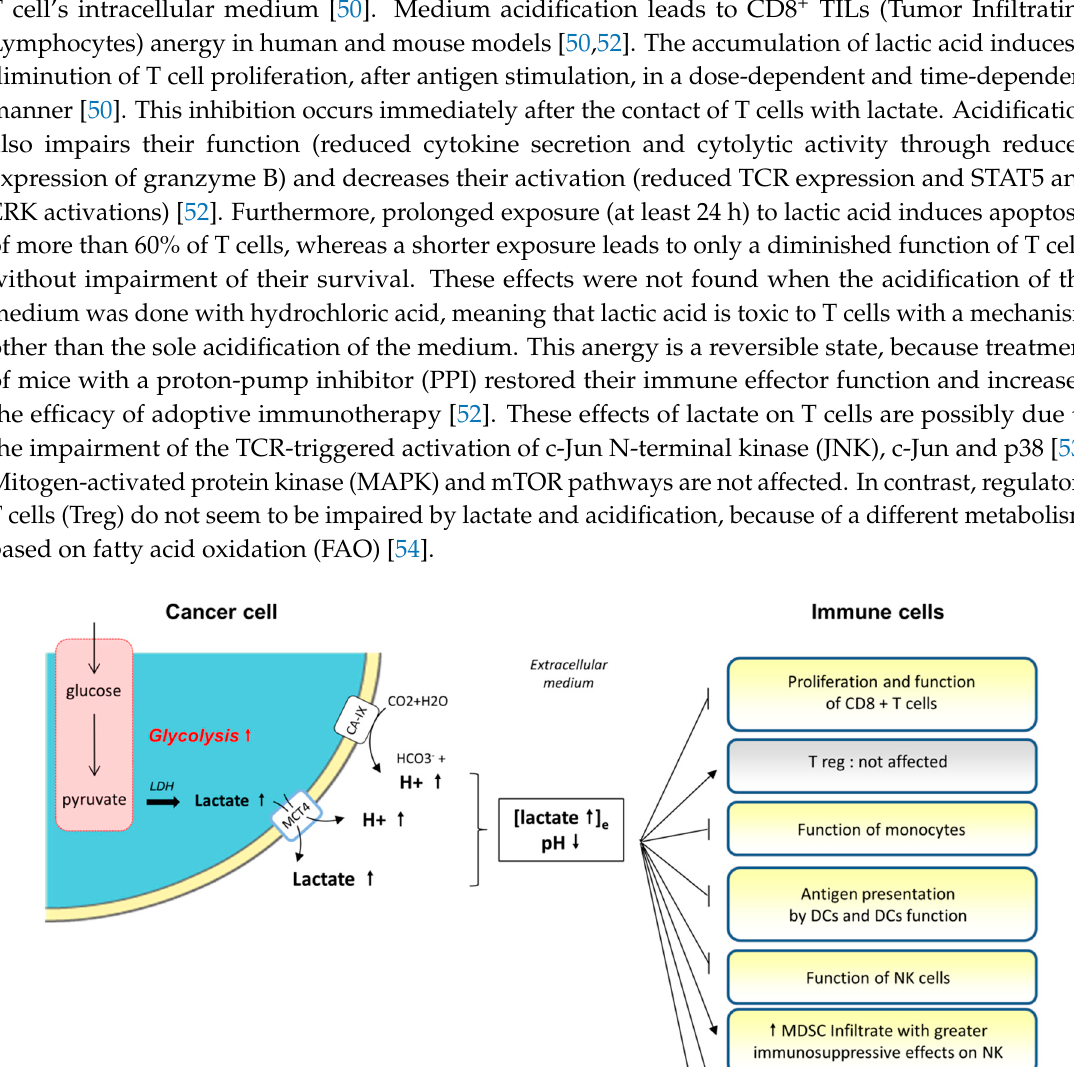
Figure 2. Cancer cells induced-lactate and -proton release within the peritumoral environment and the consequences for immune cell function. The metabolic switch towards aerobic glycolysis observed in most cancer cells (i.e., Warburg’s effect) produces significant amounts of pyruvate that are mostly metabolized into lactate. The intracellular increase of lactate, potentially toxic for the cancer cell, is then released into the extracellular medium together with protons (thanks to transporters such as MCT4), inducing an acidification of the local environment. The frequent up-regulation of carbonic anhydrase IX (CA-IX) in cancer cells also contributes to the local increase of H+ in the immediate neighborhood of cancer cells. Both, the accumulation of lactate and the decrease in the pH of the extracellular milieu create a detrimental environment for the antitumoral immune response, (i) decreasing the function of the CD8+ T cells, dendritic cells (DCs), monocytes, natural killer (NK) cells and/or (ii) increasing the myeloid-derived suppressor cells (MDSC) infiltrate or M2-polarized macrophages with greater immunosuppressive functions on NKs and T cells, respectively.